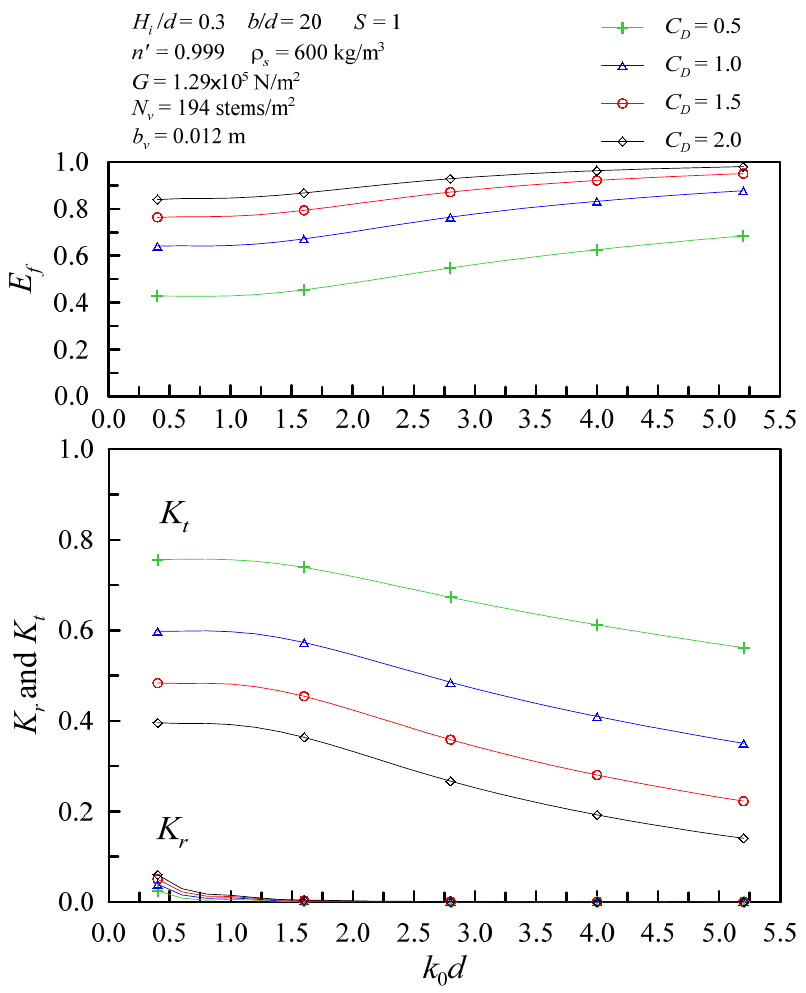
Figure 6. Effect of the drag coefficient C of vegetation on D of vegetation on K r , K t , and E f ( H i / d D b / d = 20, h / d = 1.0285, b v = 0.012 m, N v = 194 steams / m 2 , S = 1, µ = 0.333, n (cid:48) = 0.999, ρ / m 3 , ρ / m 3 , ν = 1.12 × 10 − 6 m 2 / s, β = 4.35 × 10 − 10 m 2 / N, and G = 1.29 × s = 600 kg w = 1000 kg 10 5 N / m 2